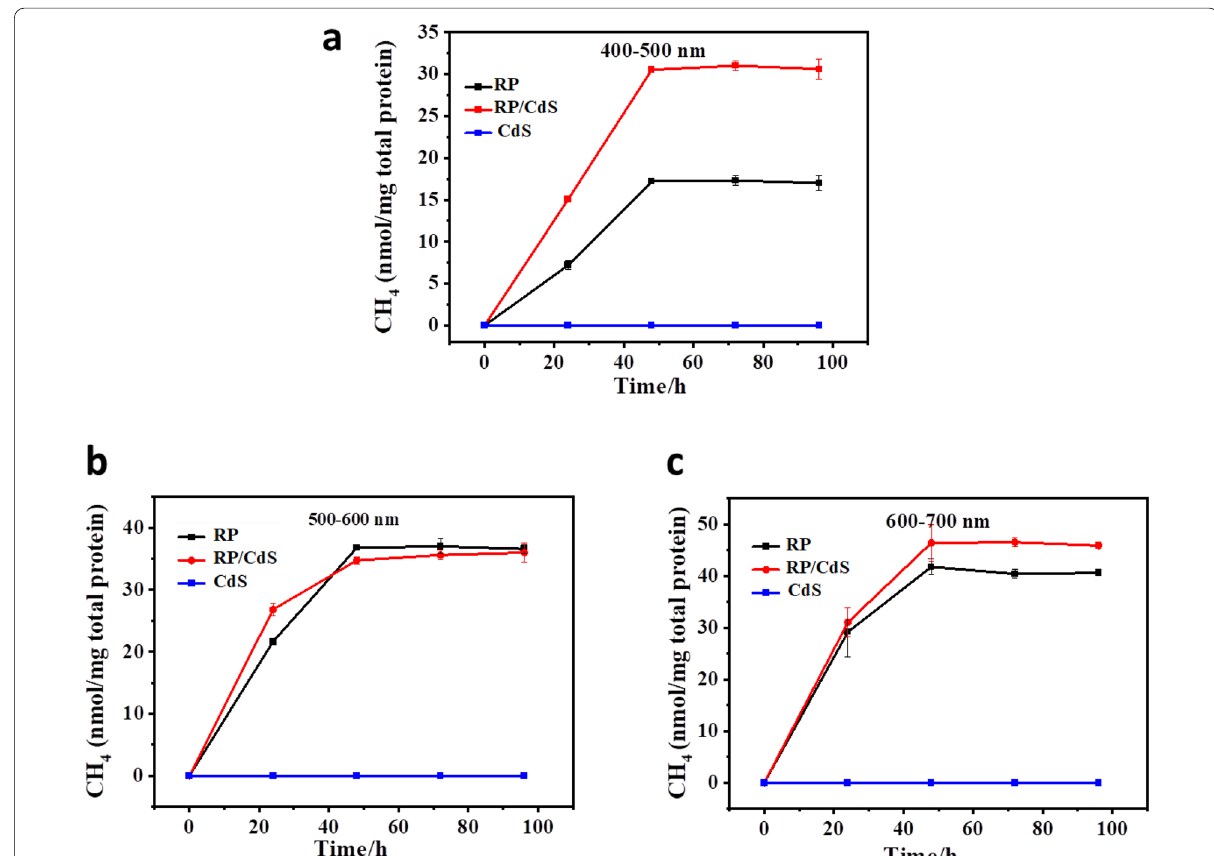
Fig.3 Biomethanation performance of RP cells and RP/CdS hybrid cells under the irradiation of light with different wavelength a 400–500 nm, b 500–600 nm, c 600–700 nm, respectively. The experiments were performed under OD660